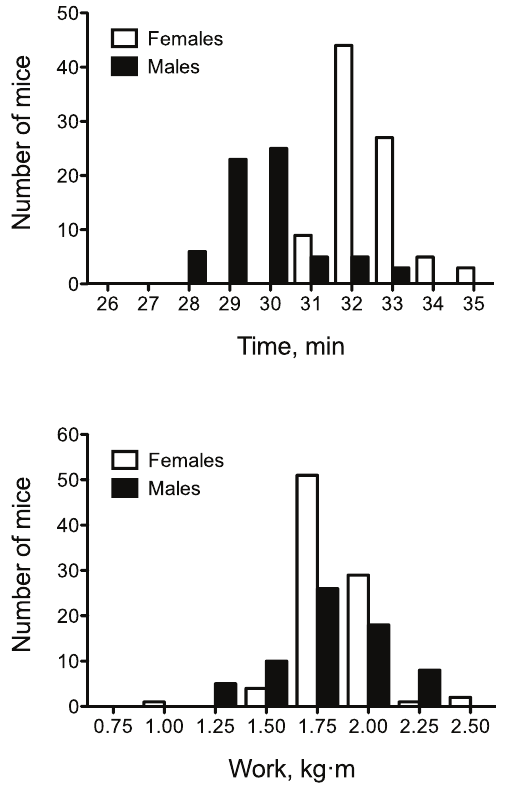
Figure 2. Frequency distribution for ( A ) time and ( B ) work in male and female (B6.A14 × B6) F mice. All F mice (n = 155) performed 2 2 a graded exercise test to exhaustion to assess exercise capacity. Mice assorted into 1min/0.25 kg·m buckets. n = 67 for males and n = 88 for